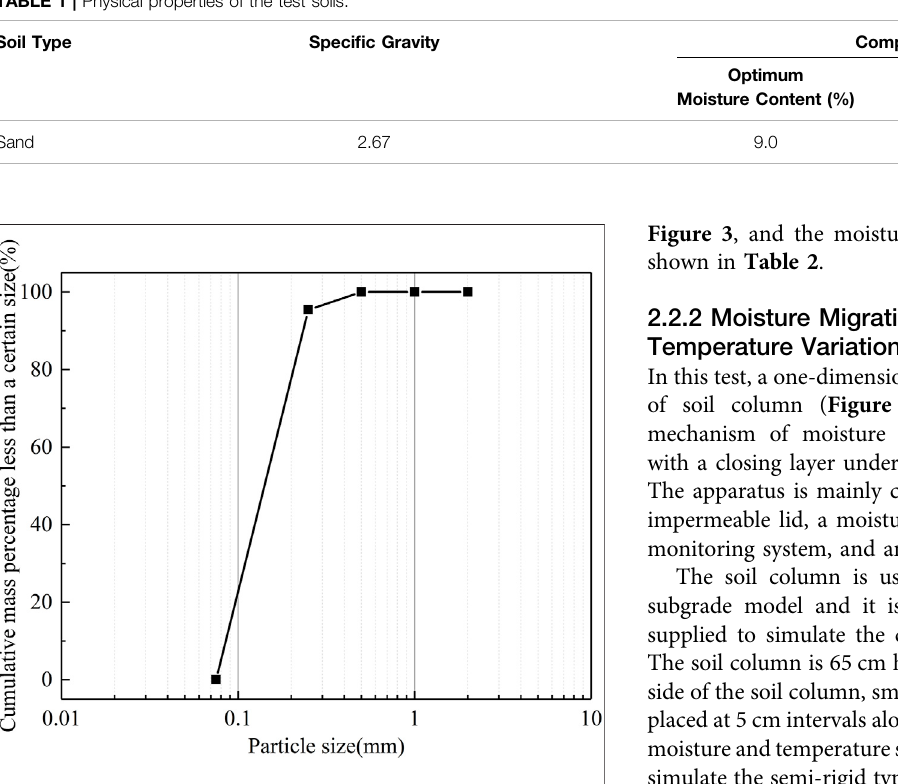
FIGURE 1 | Grain size distribution curve for the